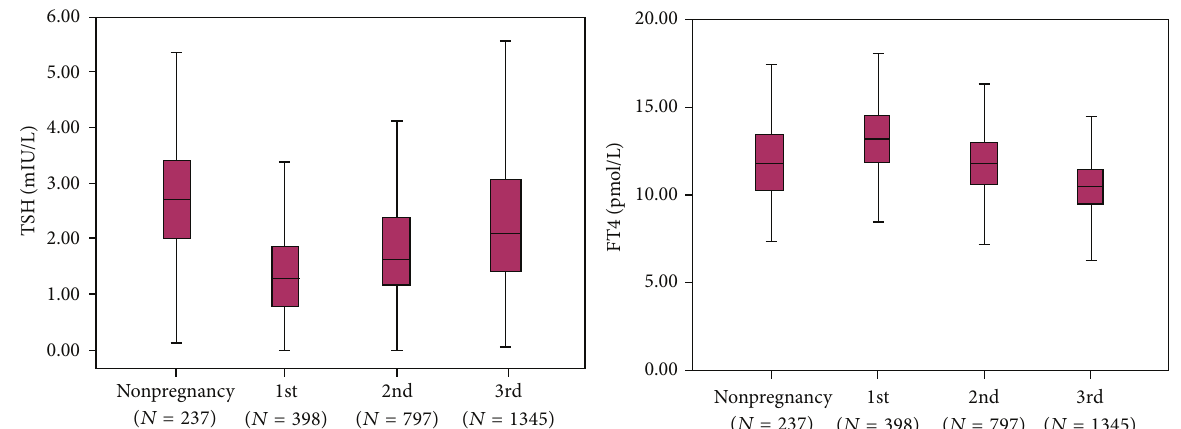
Figure 1: The trends of the TSH and FT4 levels during pregnancy and in nonpregnant women. The central box represents values from the lower to the upper quartile. The middle line represents the median, and the bars represent the 2.5th and 97.5th